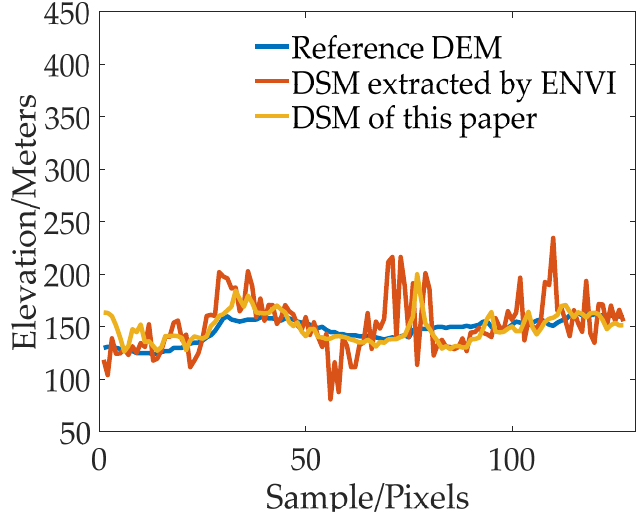
Figure 14. The elevation profile plot comparison of urban region.